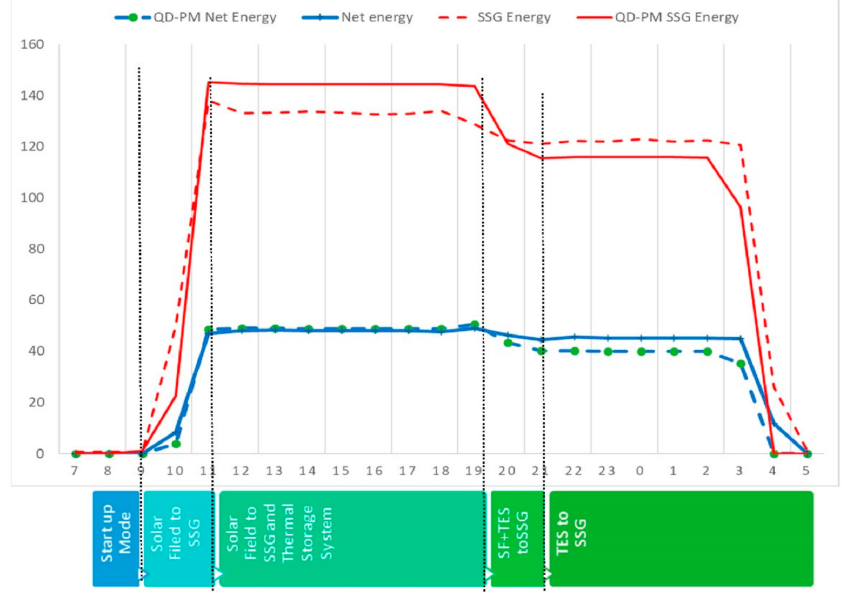
Figure 13. Operation mode evolution for a typical summer day (hourly data)